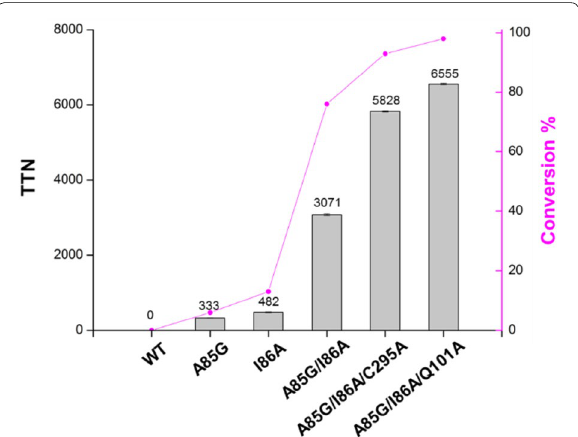
Fig. 2 Total turnover numbers (TTNs) and the conversion rate of TbSADH mutants in the reaction of ketone 1 . Reactions were done in